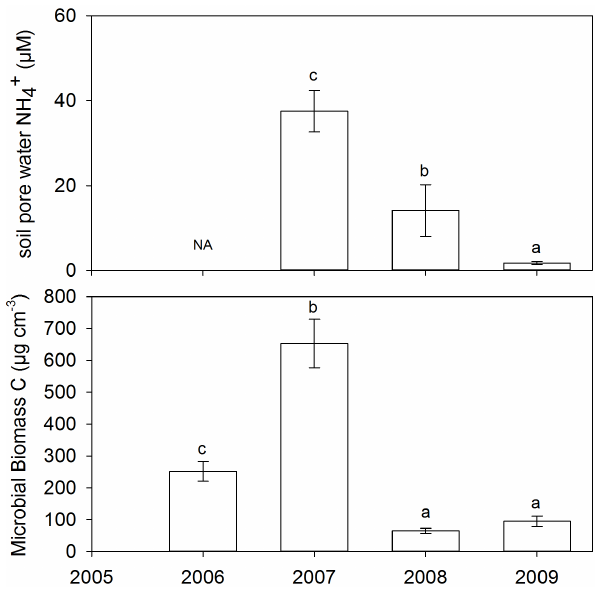
Figure 1. Soil pore water NH + and microbial biomass C in 18 and 4 36 locations respectively across the research site. Indicated are aver- ages and standard errors of the mean. NA means no data